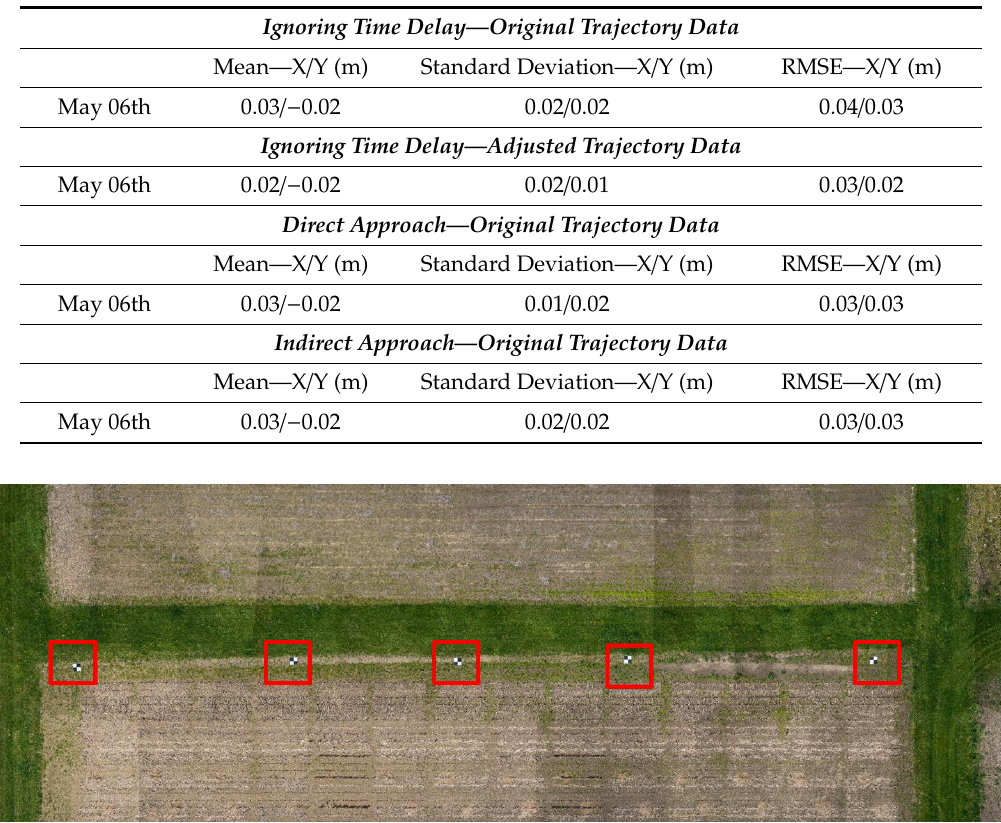
Table 17. Derived statistics of horizontal/planimetric coordinates for five check targets derived from orthophoto—DJI M600 platform.